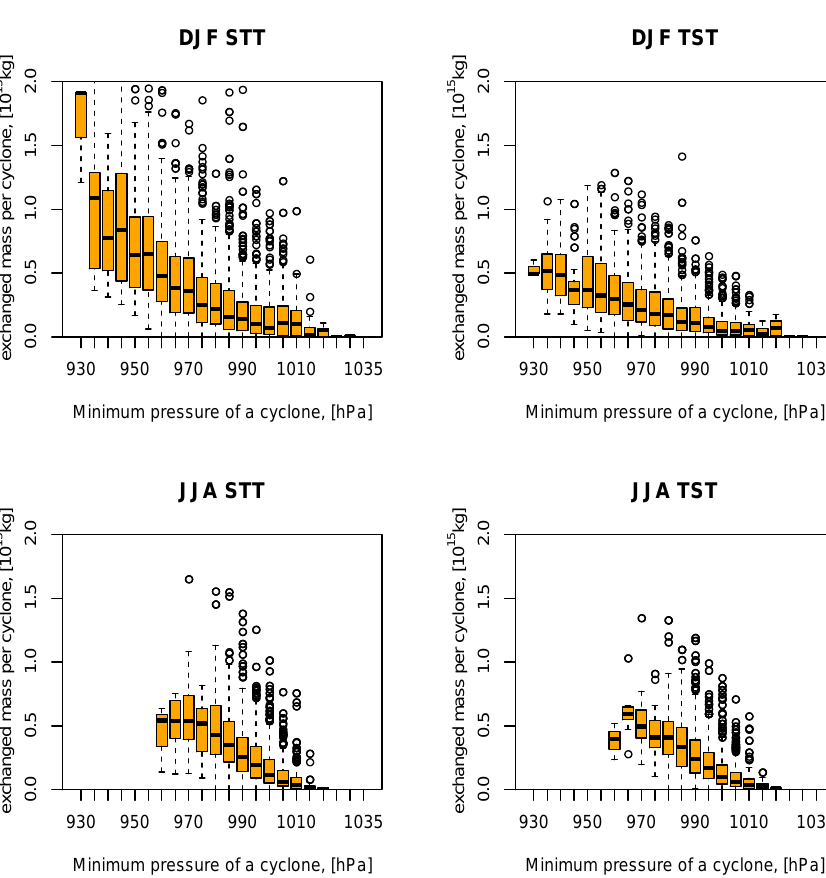
Figure 7. Box-and-Whisker plot showing the dependency of the total exchanged mass per cyclone (10 15 kg) for STT (left column) and TST (right column) on the minimum SLP of a cyclone (hPa) over the North Atlantic during DJF (upper row) and JJA (lower row).